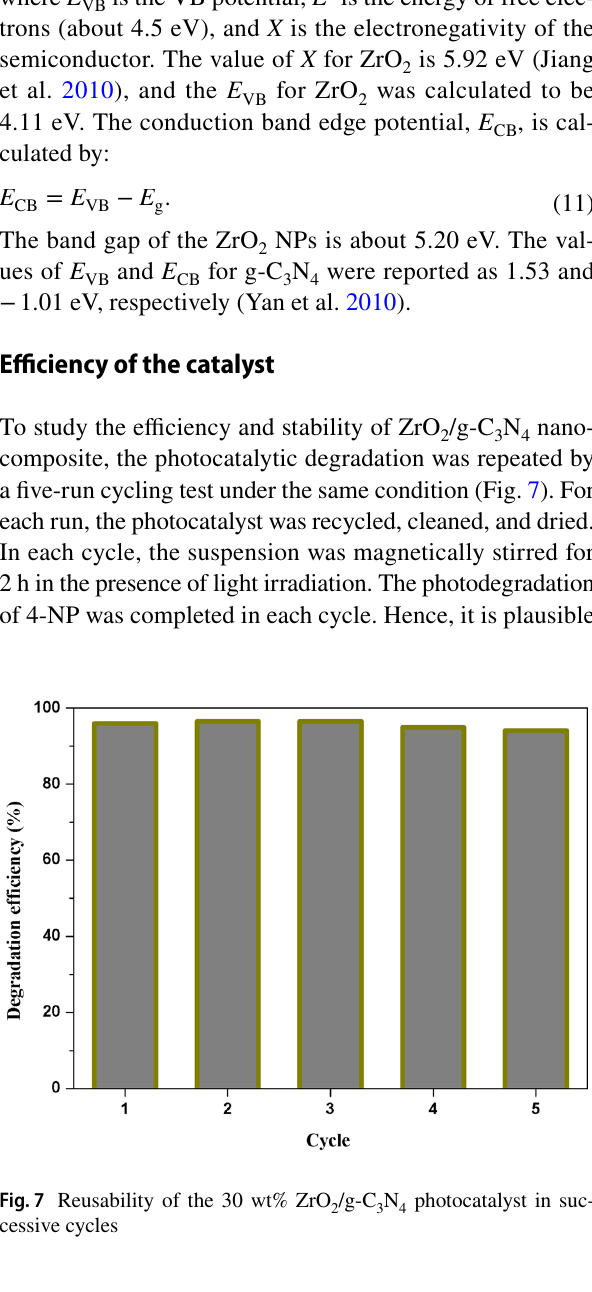
2 /g-C 3 N 4 photocatalyst in suc-